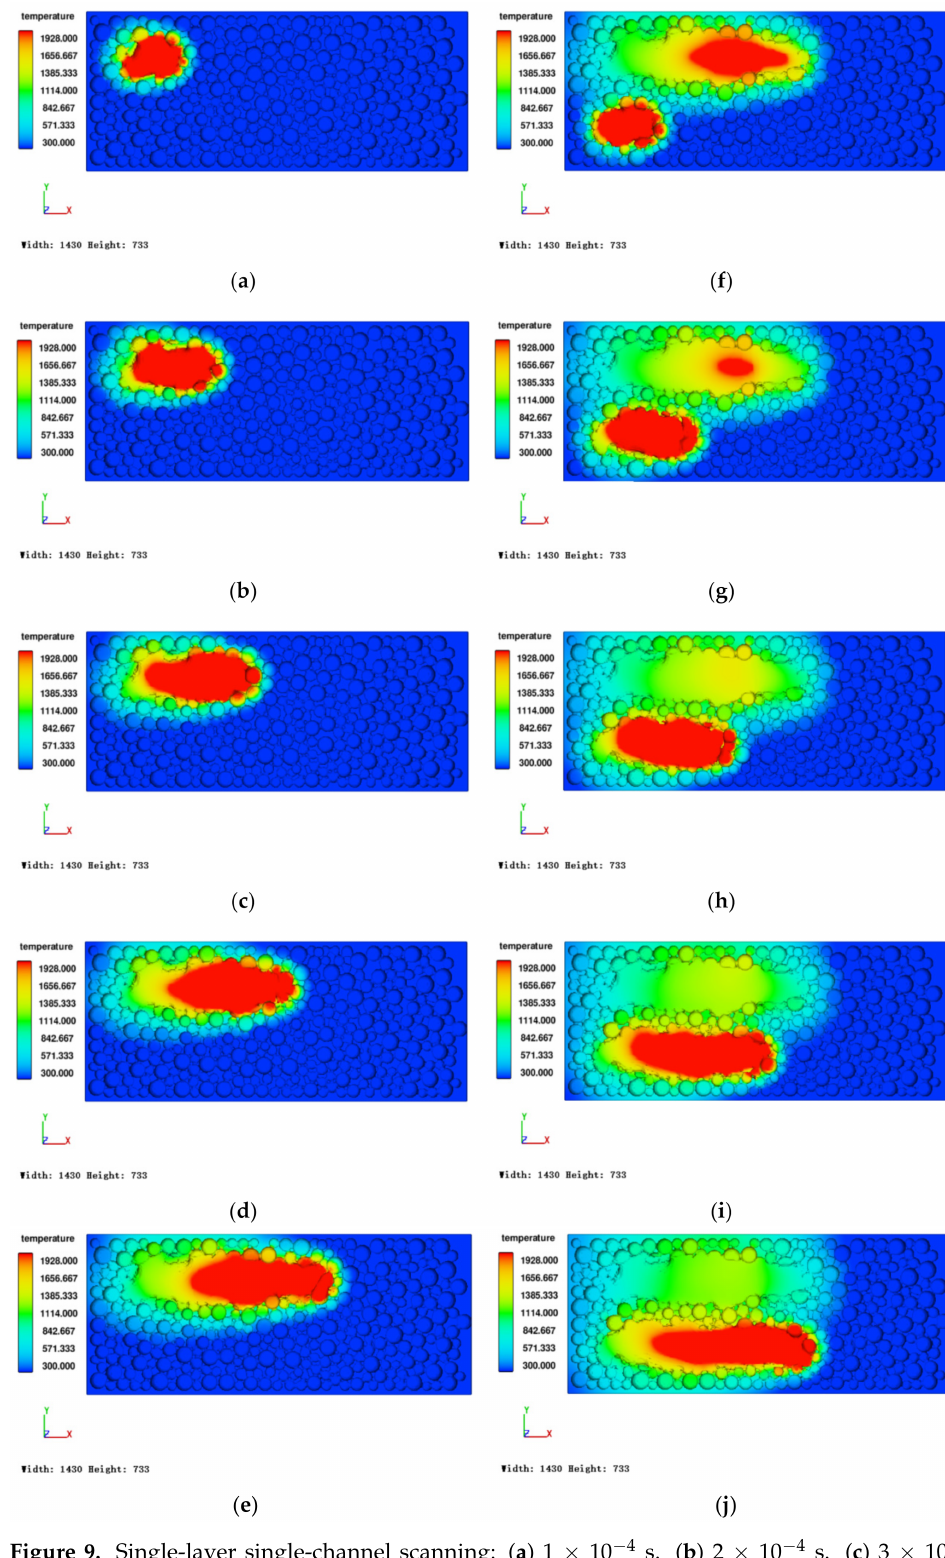
Figure 9. Single-layer single-channel scanning: ( a ) 1 × 10 − 4 s. ( b ) 2 × 10 − 4 s. ( c ) 3 × 10 − 4 s. ( d ) 4 × 10 − 4 s. ( e ) 5 × 10 − 4 s. ( f ) 6 × 10 − 4 s. ( g ) 7 × 10 − 4 s. ( h ) 8 × 10 − 4 s. ( i ) 9 × 10 − 4 s. ( j ) 10 × 10 − 4 s. Figure 10 is the YZ cross-sectional view when x = 0.17 mm, and then observe the changes in the molten pool morphology of the cross-section at different time points.